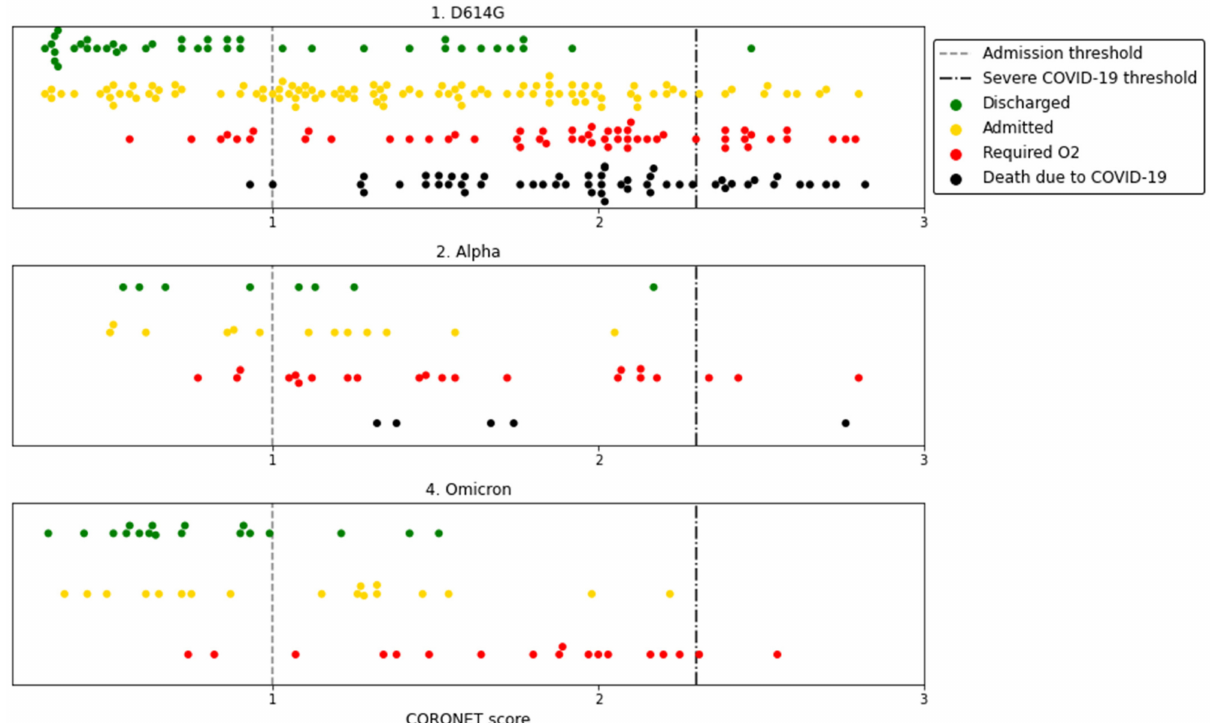
Figure 2. CORONET scores predicted for individual patients from wave 1. D614G, 2. Alpha, and wave 4. Omicron.